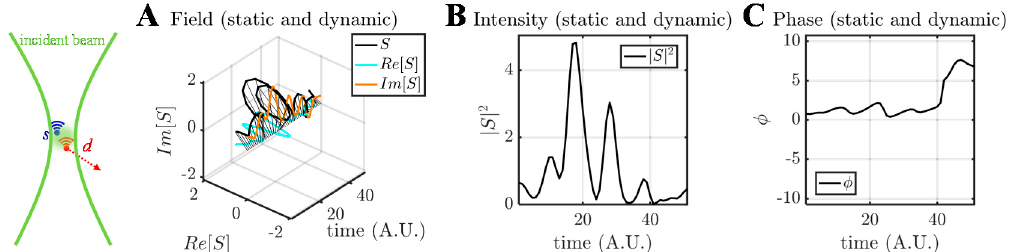
Figure 6. Comparison of complex field ( A ), intensity ( B ), and phase ( C ) time courses when both static and dynamic scattering are present in a coherence volume (with Doppler shift and decorrelation of the dynamic component). Such coherence volumes are present at the edges of vessels.